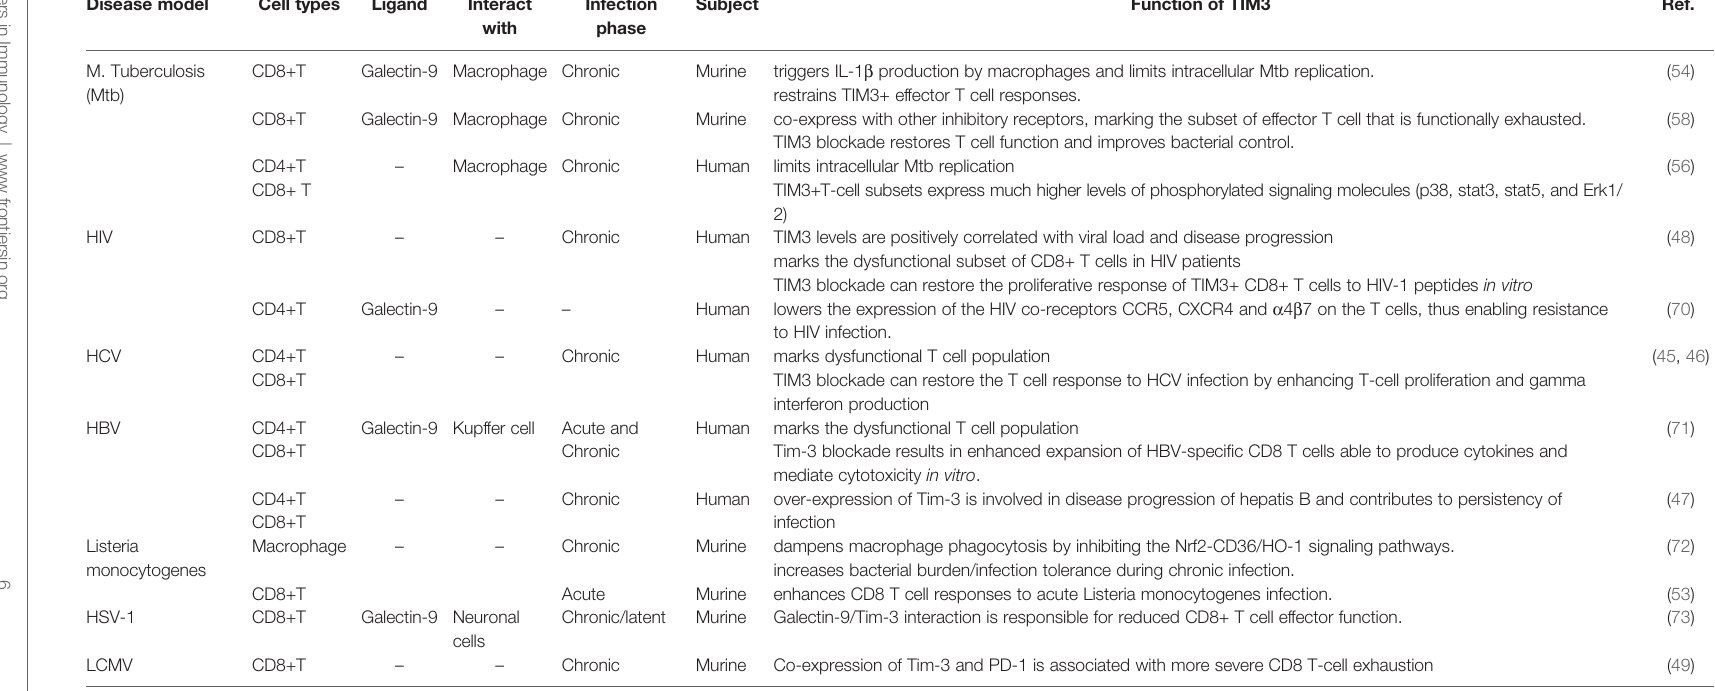
TABLE 1 | The role of TIM3 in infectious diseases. Disease